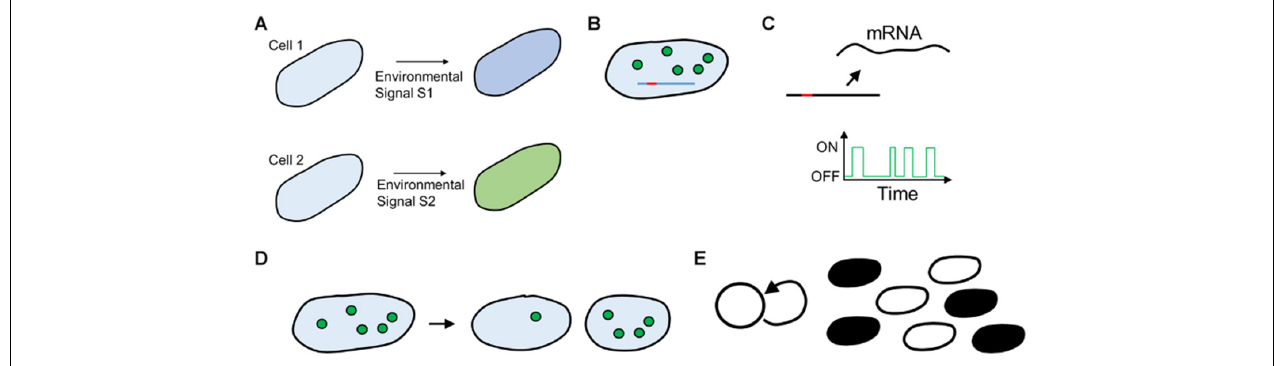
FIGURE 2 | (A) Extrinsic cause of heterogeneity. Two isogenic cells are fed dissimilar signals because of environmental noise, leading to different responses. (B–E) Cell–cell heterogeneity because of intracellular noise. (B) Small number of Transcription Factor molecules (circles) take widely different time to search for the promoter site (red) on DNA (blue line). (C) Cellular processes such as transcription occur with exponentially distributed periods of bursts of activity. (D) Cell–cell variation because of unequal partitioning at cell division, (E) Feedback in cellular networks leads to all (black) or none (white) states in cellular